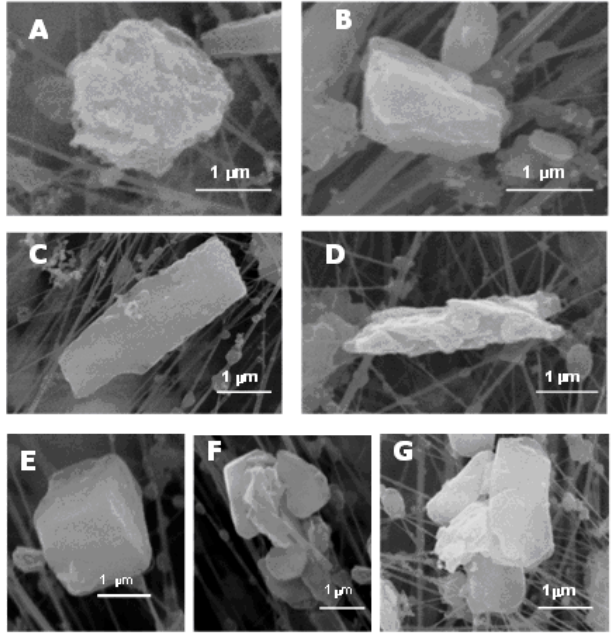
Figure 2. Scanning electron microscopy (SEM) images of suspended particulate matter: ( A ) allotriomorphous particle; ( B ) subidiomorphous particle; ( C ) tabular; ( D ) acicular; ( E ) cubic crystal; ( F ) rosette-shape particle; ( G ) mineral aggregates.